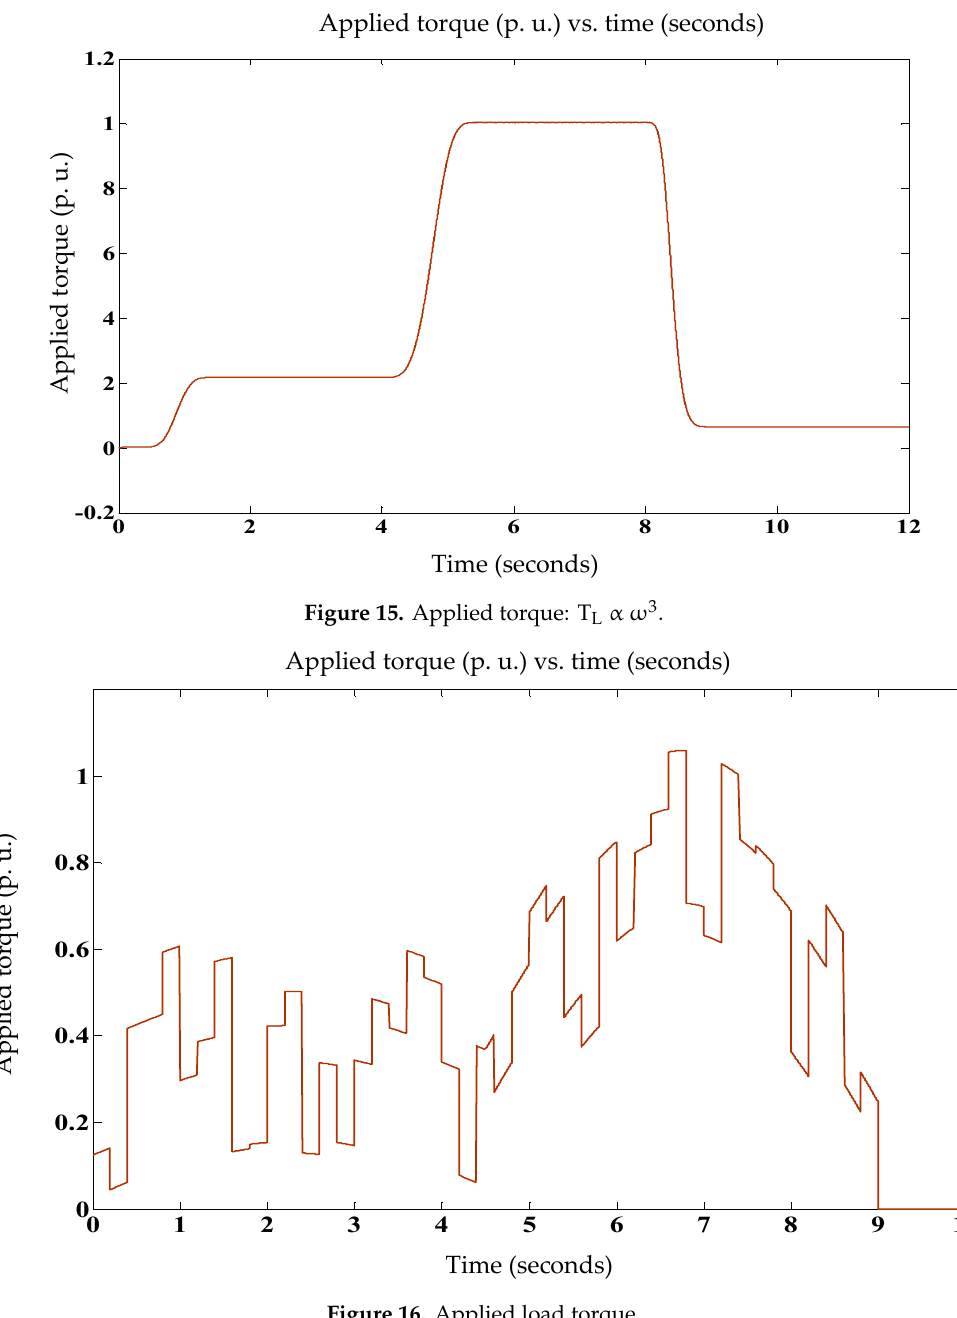
Figure 16. Applied load torque.